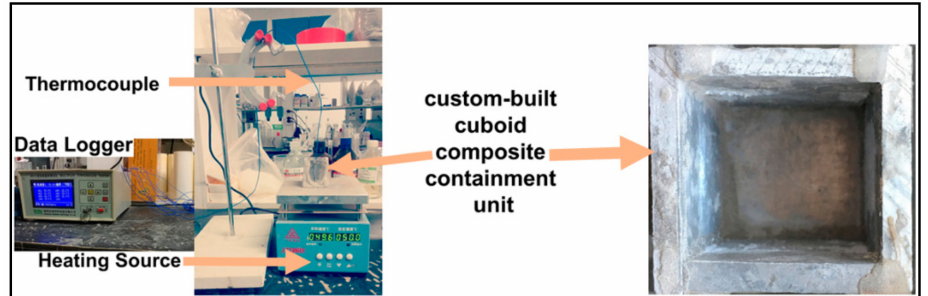
Figure 1. Experimental method description for the thermal analysis of